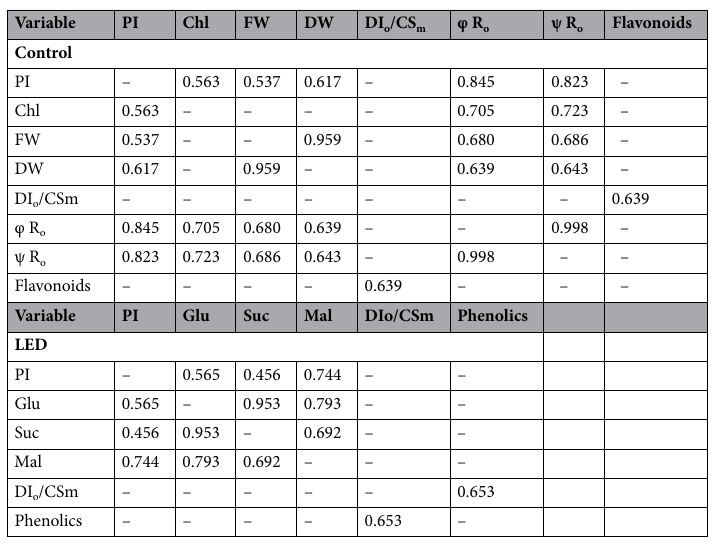
Table 5. Pearson coefficients of linear correlation ( p < 0.05) between selected studied parameters of common buckwheat cv. ‘Panda’ grown under different controlled-environment production systems. Control—solar light supplemented with HPS (High-Pressure Sodium) lamps; LED (Light-Emitting Diodes); PI—performance index of PSII, Chl—chlorophyll index, FW—fresh weight, DW—dry weight, DI o /CS m —energy dissipation from PSII, ψ Ro—probability, at time 0, that a trapped exciton moves an electron into the electron transport chain beyond Q A − , φ Ro—quantum yield of electron transport from Q A− to the PSI end electron acceptors, Glu—glucose, Suc—sucrose,